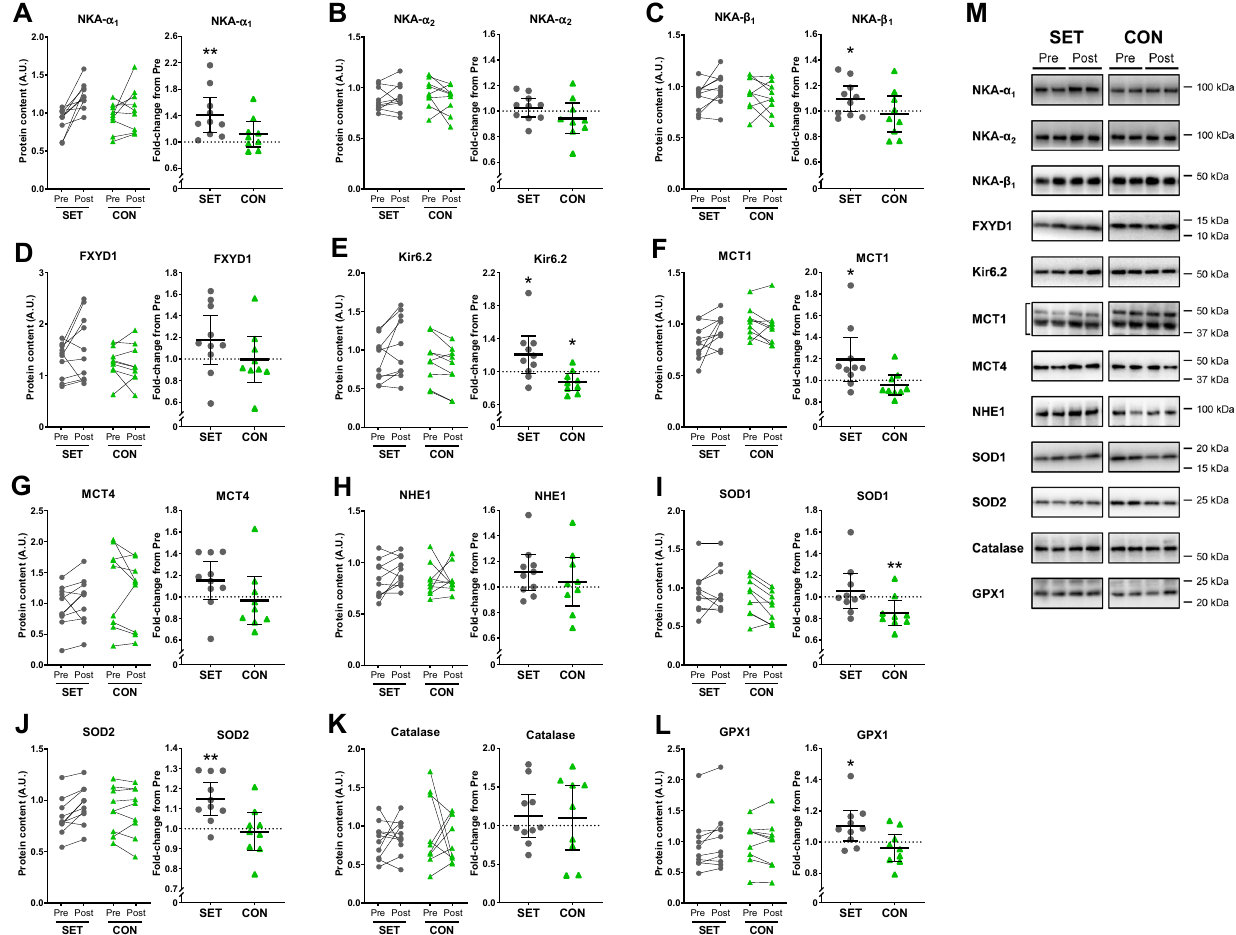
Figure 10. Effect of speed endurance training (SET) on the muscle content of ion-handling proteins and antioxidant enzymes. Change in the muscle content of ion-handling proteins ( A – H ) and antioxidant enzymes ( I – L ) as well as representative blots ( M ) before (pre) to after (post) the SET intervention (SET, n = 10) or habitual lifestyle maintenance (CON, n = 9). NKA, Na + /K + -ATPase; FXYD1, regulatory subunit of NKA; Kir6.2, ATP-sensitive K + -channel subunit Kir6.2; MCT, monocarboxylate transporter; NHE1, Na + /H + exchanger; SOD, superoxide dismutase; GPX, glutathione peroxidase. ** Post different from pre ( p < 0.01). * Post different from pre ( p < 0.01). Data are presented as individual pre and post values and as mean fold change ± 95% CI relative to pre with individual changes.